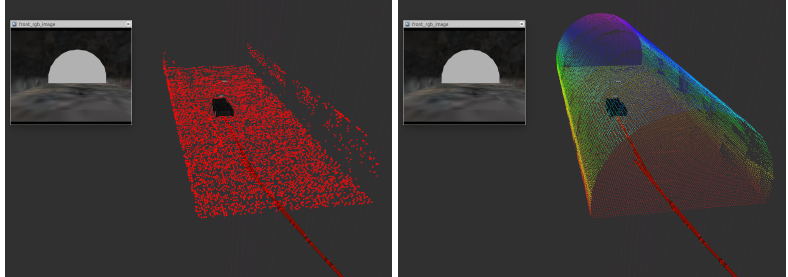
Figure 2. Pointclouds examples. Left: local point cloud used as sampling space for the RRT ∗ planner in red color. Right: local point cloud employed by the RRT ∗ for traversability analysis